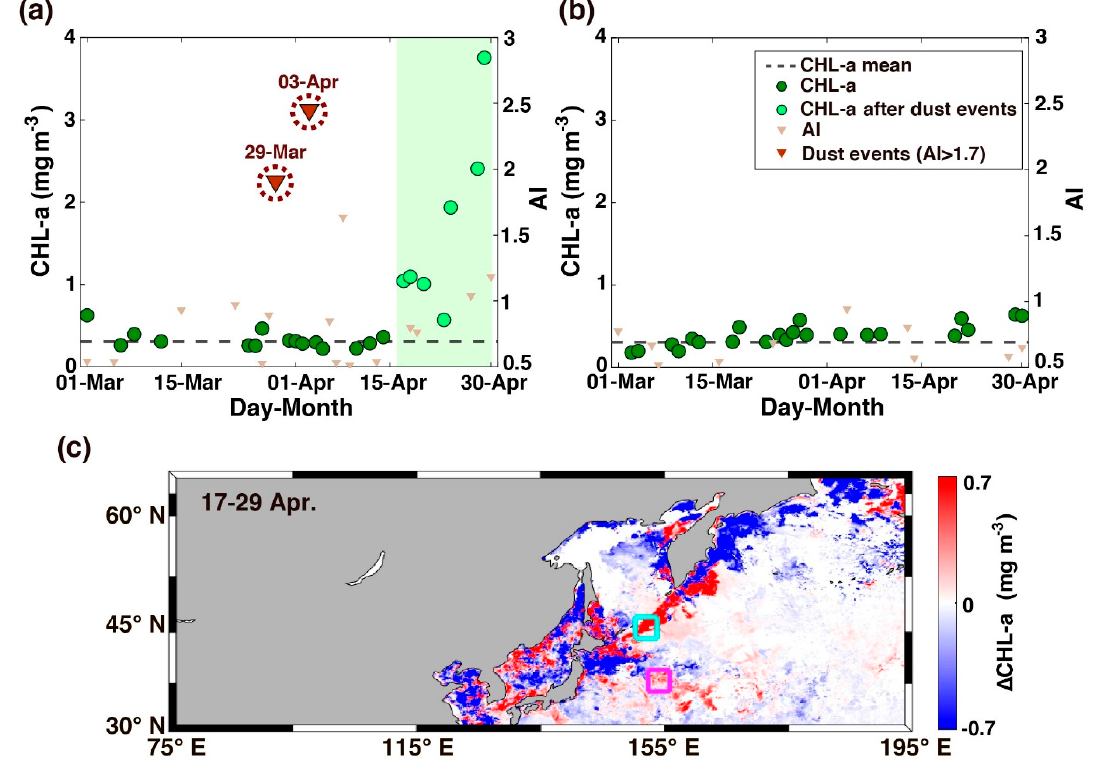
Figure 7. Daily AI values (triangles) and daily CHL-a concentrations (mg m − 3 , circles) during the 2018 spring in ( a ) dust-affected area (cyan square in Figure 7c), ( b ) area with no dust (pink square in Figure 7c) in the North Pacific Ocean. The black dotted line indicates mean CHL-a concentrations averaged for values from March to April in 2012 ‒ 2017. The green shading highlights enhanced CHL-a feature driven by strong spring Asian dust. ( c ) Spatial distributions of Δ CHL-a (mg m − 3 ) for 17–29 April 2018.